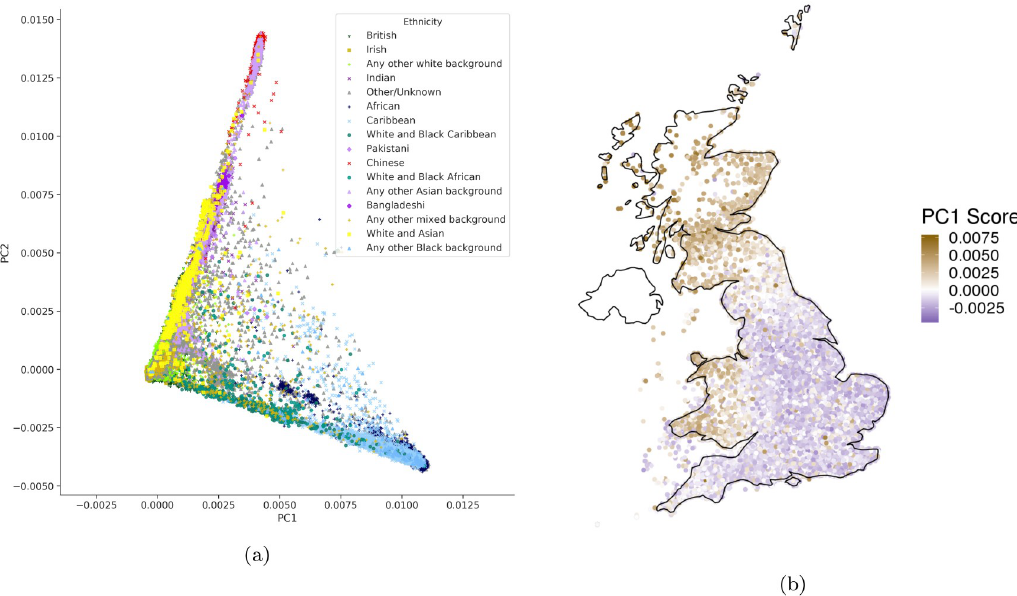
Fig 2. Principal components uncover population and geographic structure in the UK Biobank. We used ProPCA to compute PCs on the UK Biobank data. Figure 2a shows the first two principal components to reveal population structure. Figure 2b shows geographic structure by plotting the score of 276, 736 unrelated White British individuals on the first principal component on their birth location coordinates.